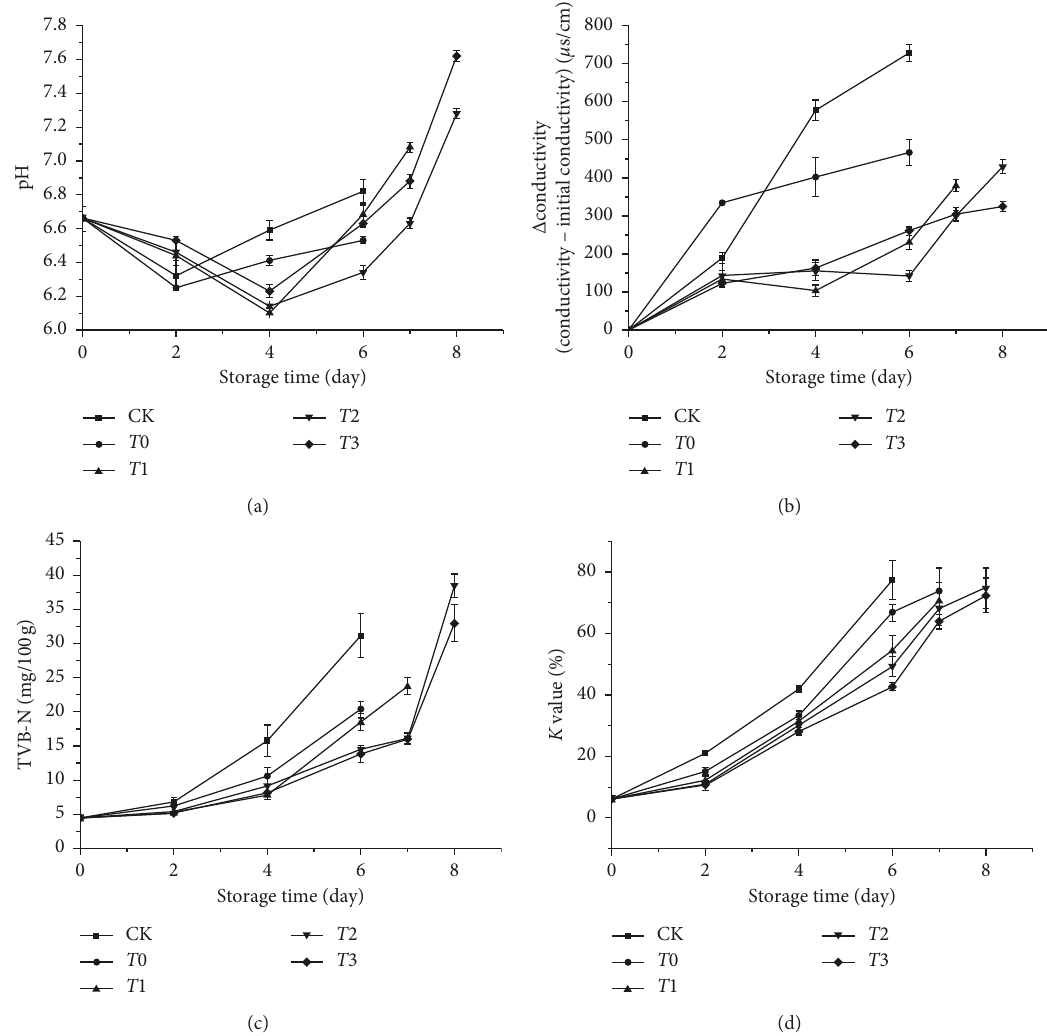
Figure 2: Change in pH values, electrical conductivity, TVB-N, and K value of crayfish during storage at 4 °